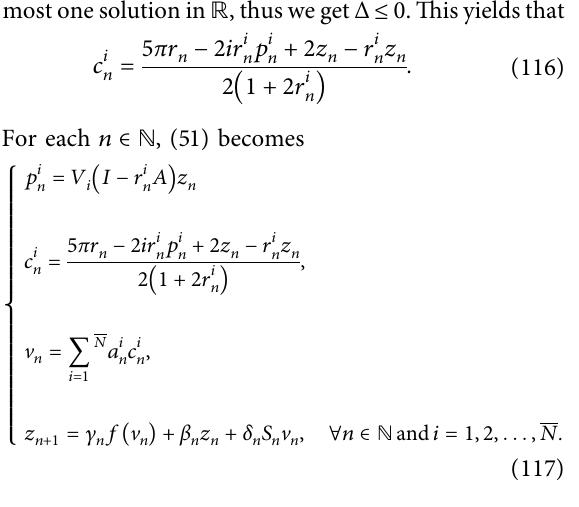
From Theorem 2, z n generated by (117) converge strongly to π , for every i The numerical values of all sequences z n